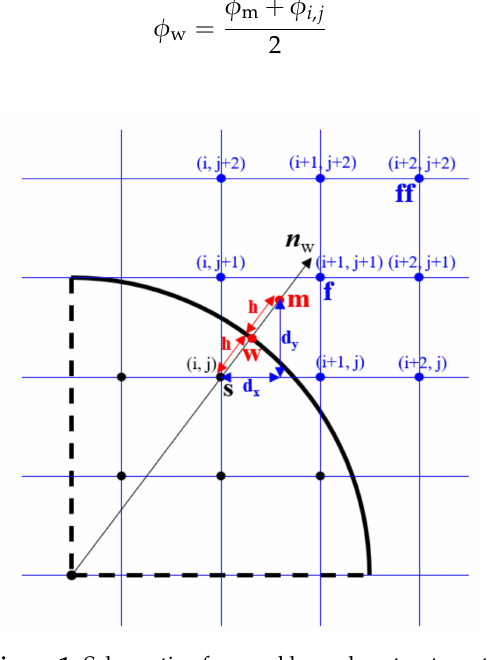
Figure 1. Schematic of curved boundary